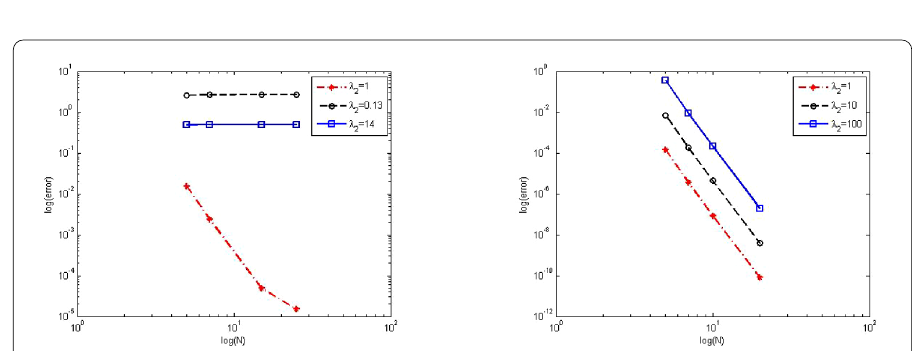
Figure 5 The error curves issued from the solution defined in